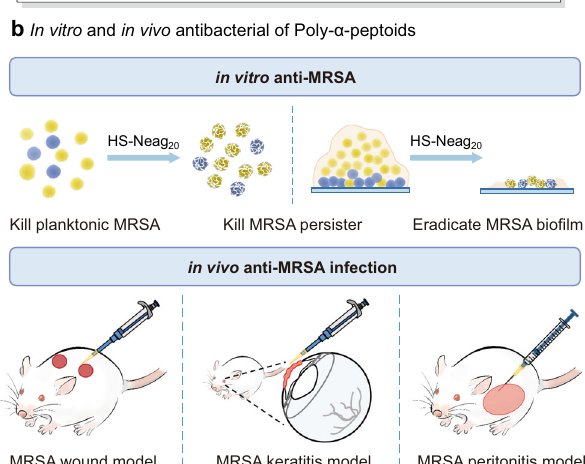
Fig. 1 Design and synthesis of peptoid polymers with anti-MRSA activity. a Synthesis of poly- α -peptoids bearing variable C-terminal functional groups. n represents the average number of repeating units within the peptoid polymer chain, that is, the degree of polymerization. b Schematic illustration on the antibacterial performance of poly-Naeg, in vitro and in